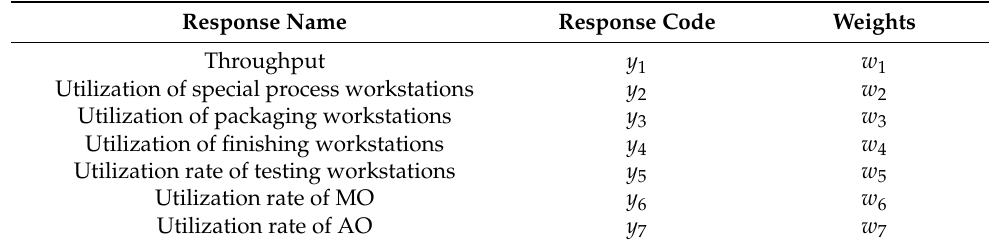
Table 2. Responses of System Performance